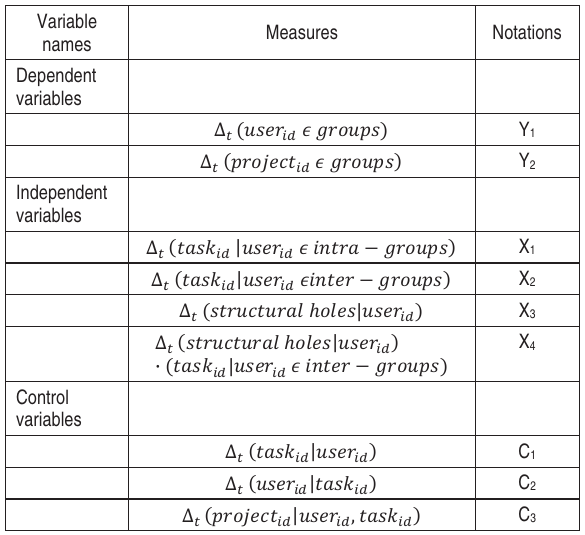
Table 3. List of